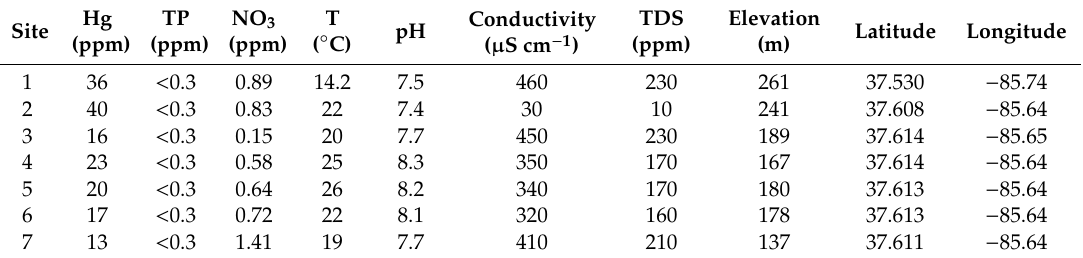
Table 2. Averaged environmental data of the sampling stations in the Abraham Lincoln Birthplace National Historical Park with its geographical